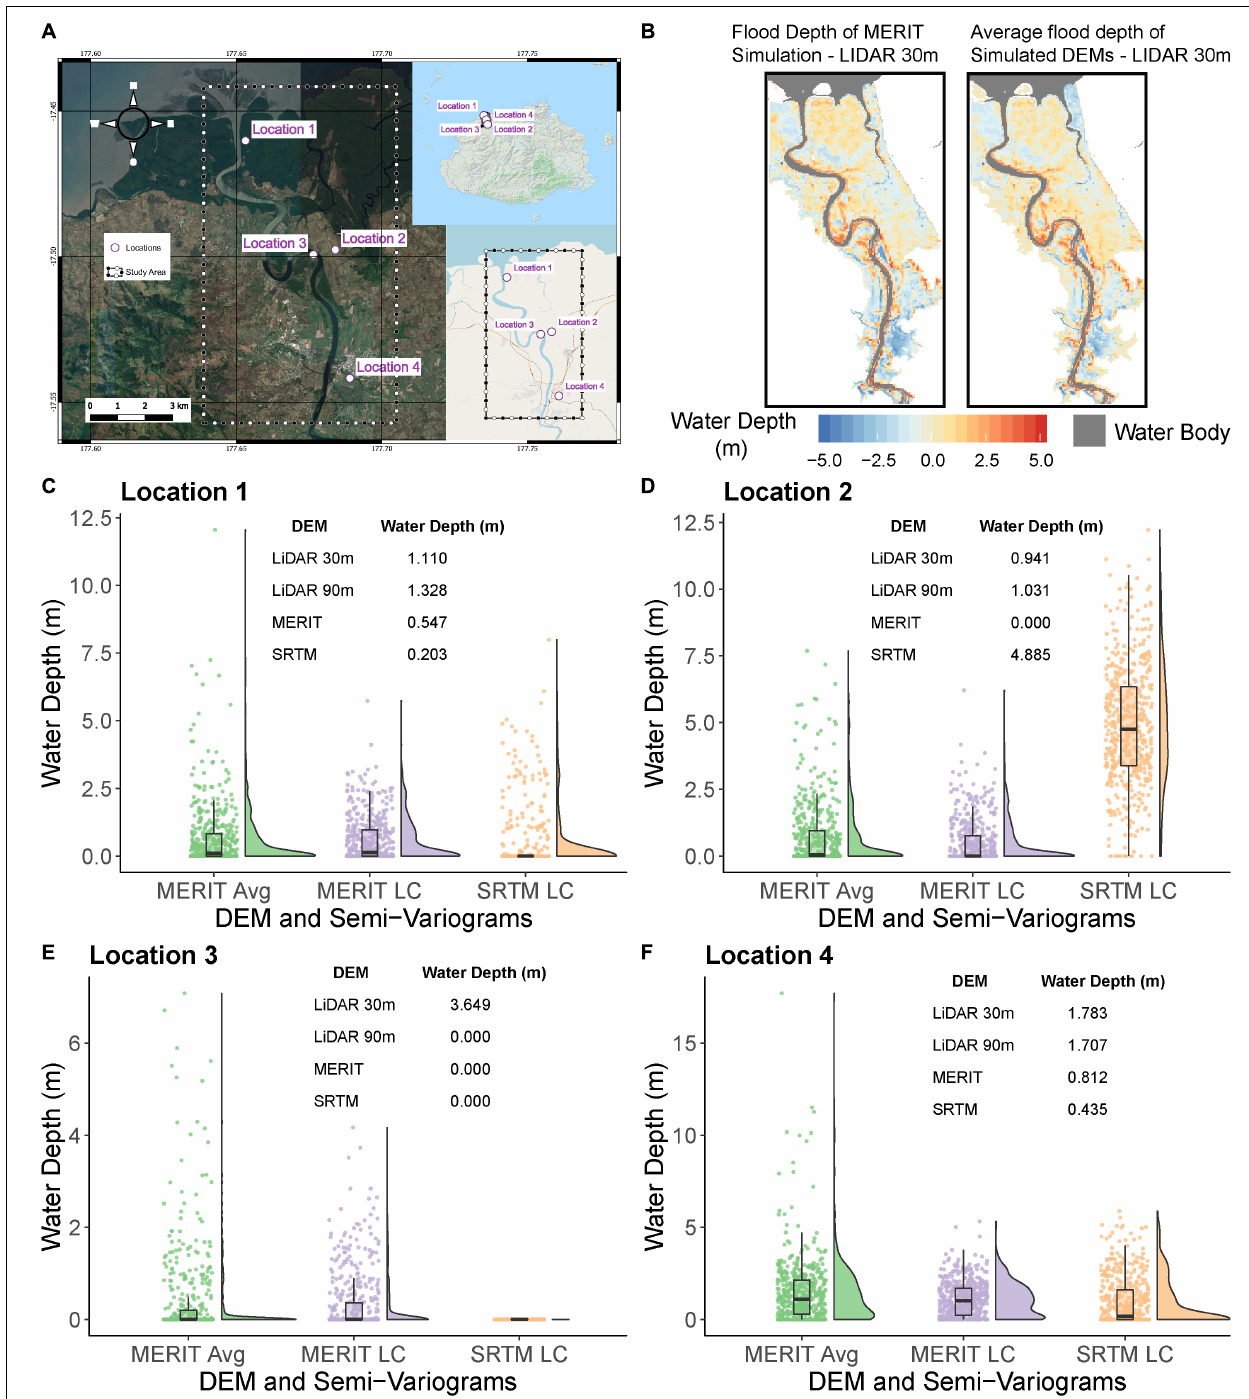
FIGURE 2 | Maximum flood water depth at four locations in Ba, Fiji for a 50-year return period event. (A) Overview of study area, with locations of four random locations to investigate differences in water depth. (B) Average flood depth for models run with MERIT DEM and simulated versions of the MERIT DEM simulated using semi-variograms per landcover class against the LIDAR 30 m model. (C) Maximum water depth distribution of each DEM ensemble simulated by different sets of semi-variograms for location 1. (D) Maximum water depth distribution of each DEM ensemble simulated by different sets of semi-variograms for location 2. (E) Maximum water depth distribution of each DEM ensemble simulated by different sets of semi-variograms for location 3. (F) Maximum water depth distribution of each DEM ensemble simulated by different sets of semi-variograms for location 4. MERIT Avg refers to MERIT DEM simulated using an ‘average’ floodplain semi-variogram, MERIT LC refers to MERIT DEM simulated using semi-variograms by landcover class, SRTM LC refers to SRTM DEM simulated using semi-variograms by landcover class.